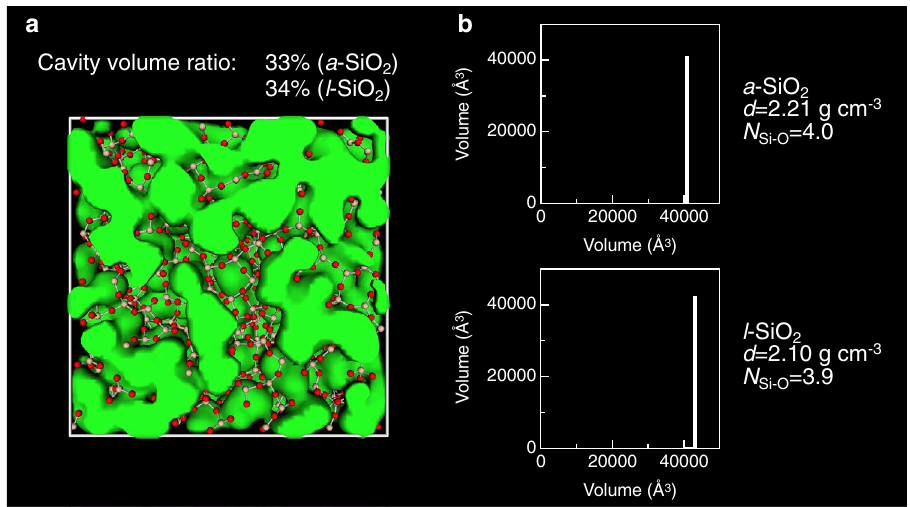
Figure 5. ( a ) Visualization of cavities in a -SiO 229 and ( b ) Cavity size distributions in a - and l -SiO 2 (2373 K). The cavity volume ratio of l -SiO 2 was calculated on the basis of the atomic configuration obtained by MD simulation. Only the a -SiO 2 configuration is shown, because it is difficult to distinguish between a -SiO 2 and l -SiO 2 by visual inspection.